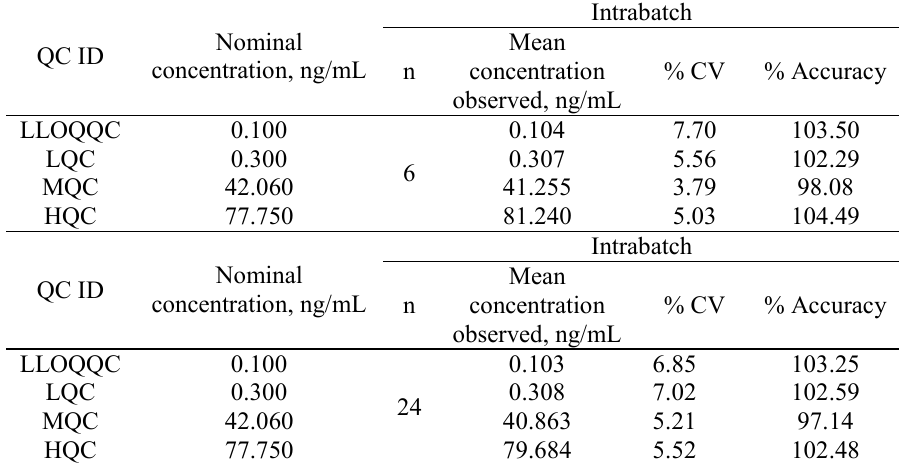
Table 1. (A). Comparison of intra- and inter-batch precision and accuracy for